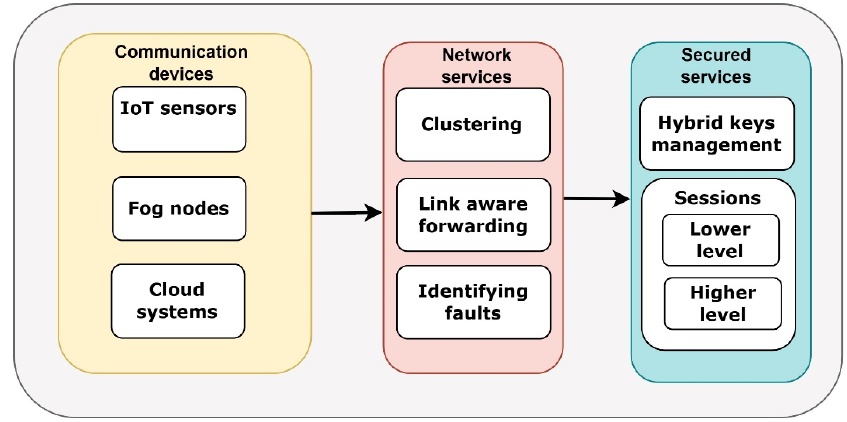
Figure 1. Various stages of the proposed protocol.